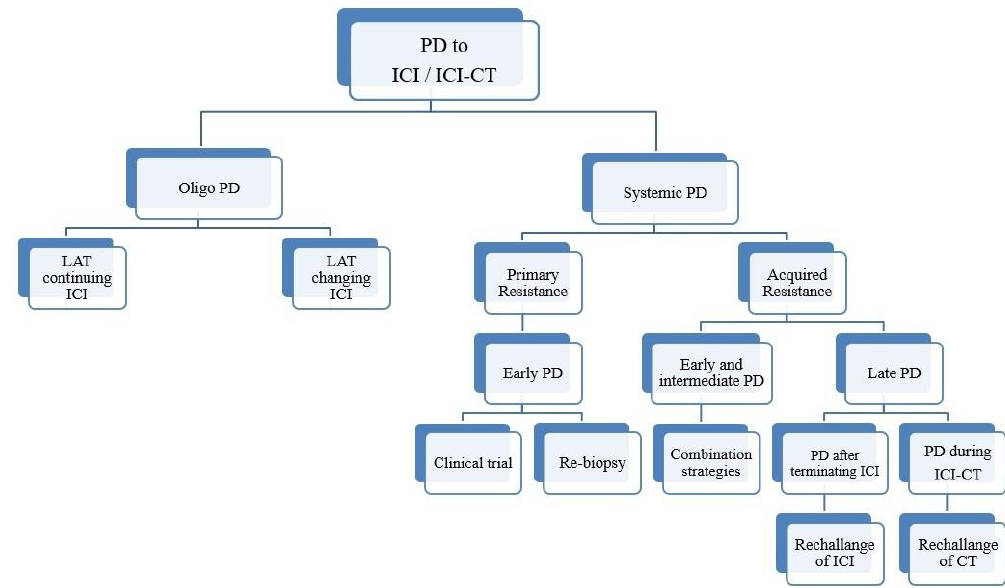
Figure 1. Schematic representation of an algorithm for patients with NSCLC who progressed upon IO-based therapy. Funding: No funding was received.